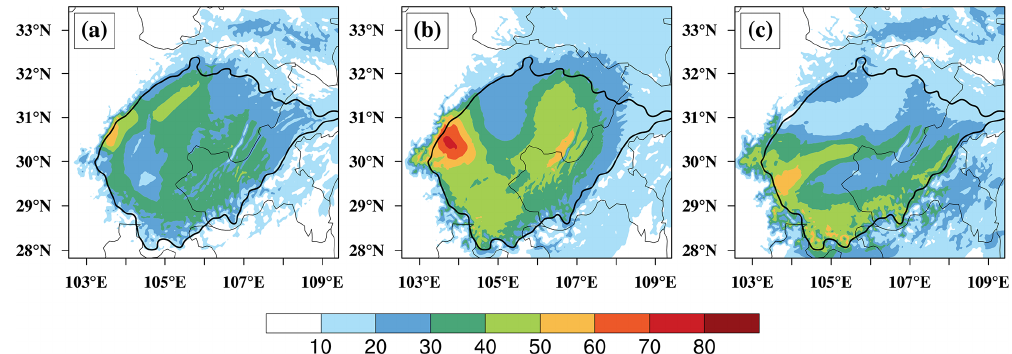
Figure 10. Horizontal distribution of PM 2 . 5 concentrations (color contours: µgm − 3 ) averaged between 1.5 and 2.5km heights (in the lower free troposphere) for (a) formation, (b) maintenance, and (c) dissipation periods of a heavy haze pollution event over the SCB. The SCB was outlined with an altitude contour of 750m in a.s.l. (dark black lines).